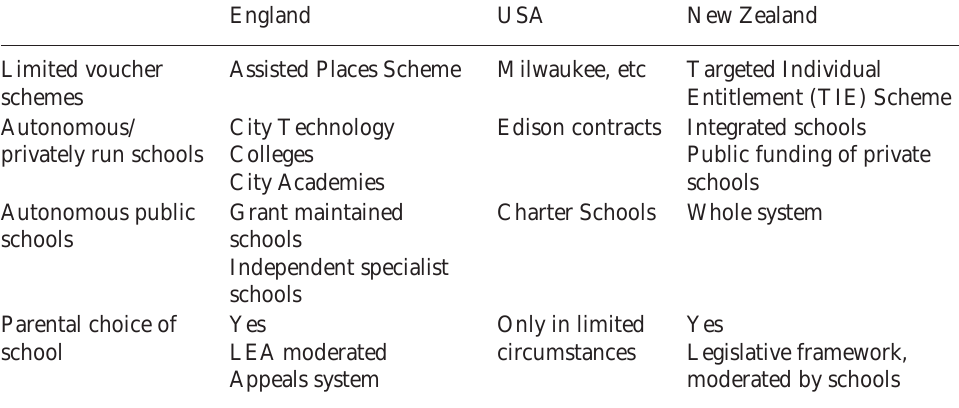
Table 1 Some policies of privatisation in selected